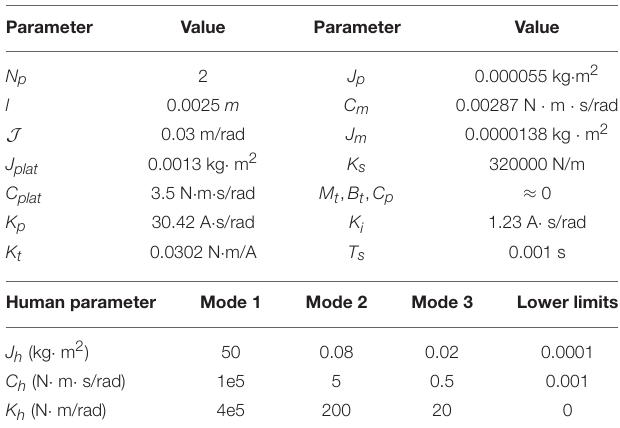
TABLE 1 | Platform and human